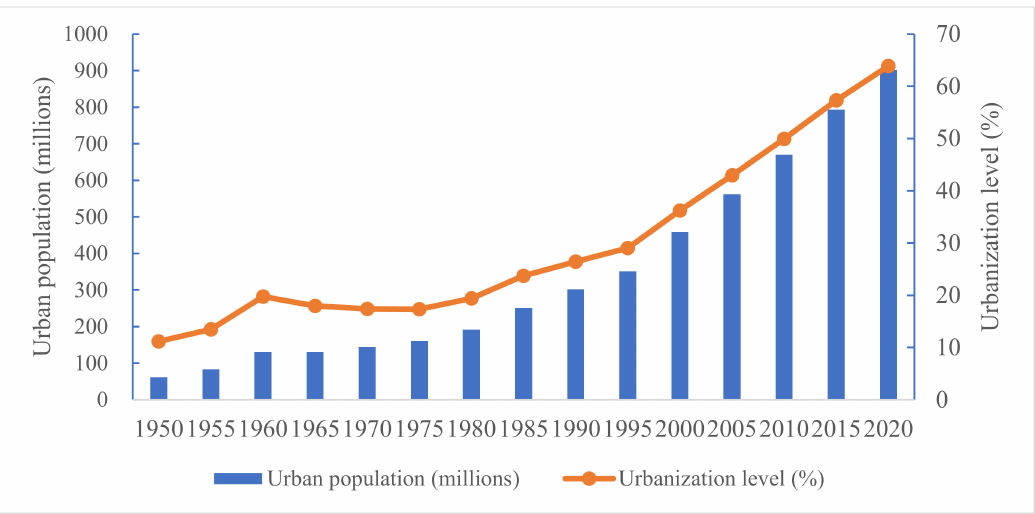
Figure 1. Urbanization in China, 1950–2020 (Source: National Bureau of